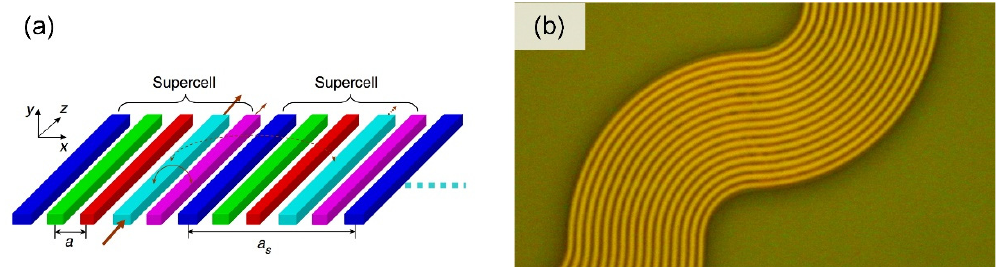
Figure 8. ( a ) The schematic of a waveguide superlattice array from [73]; ( b ) a microscopy image of the curved waveguide array [76]. Reproduced with permission from [73]. the curved waveguide array [76]. Reproduced with permission from